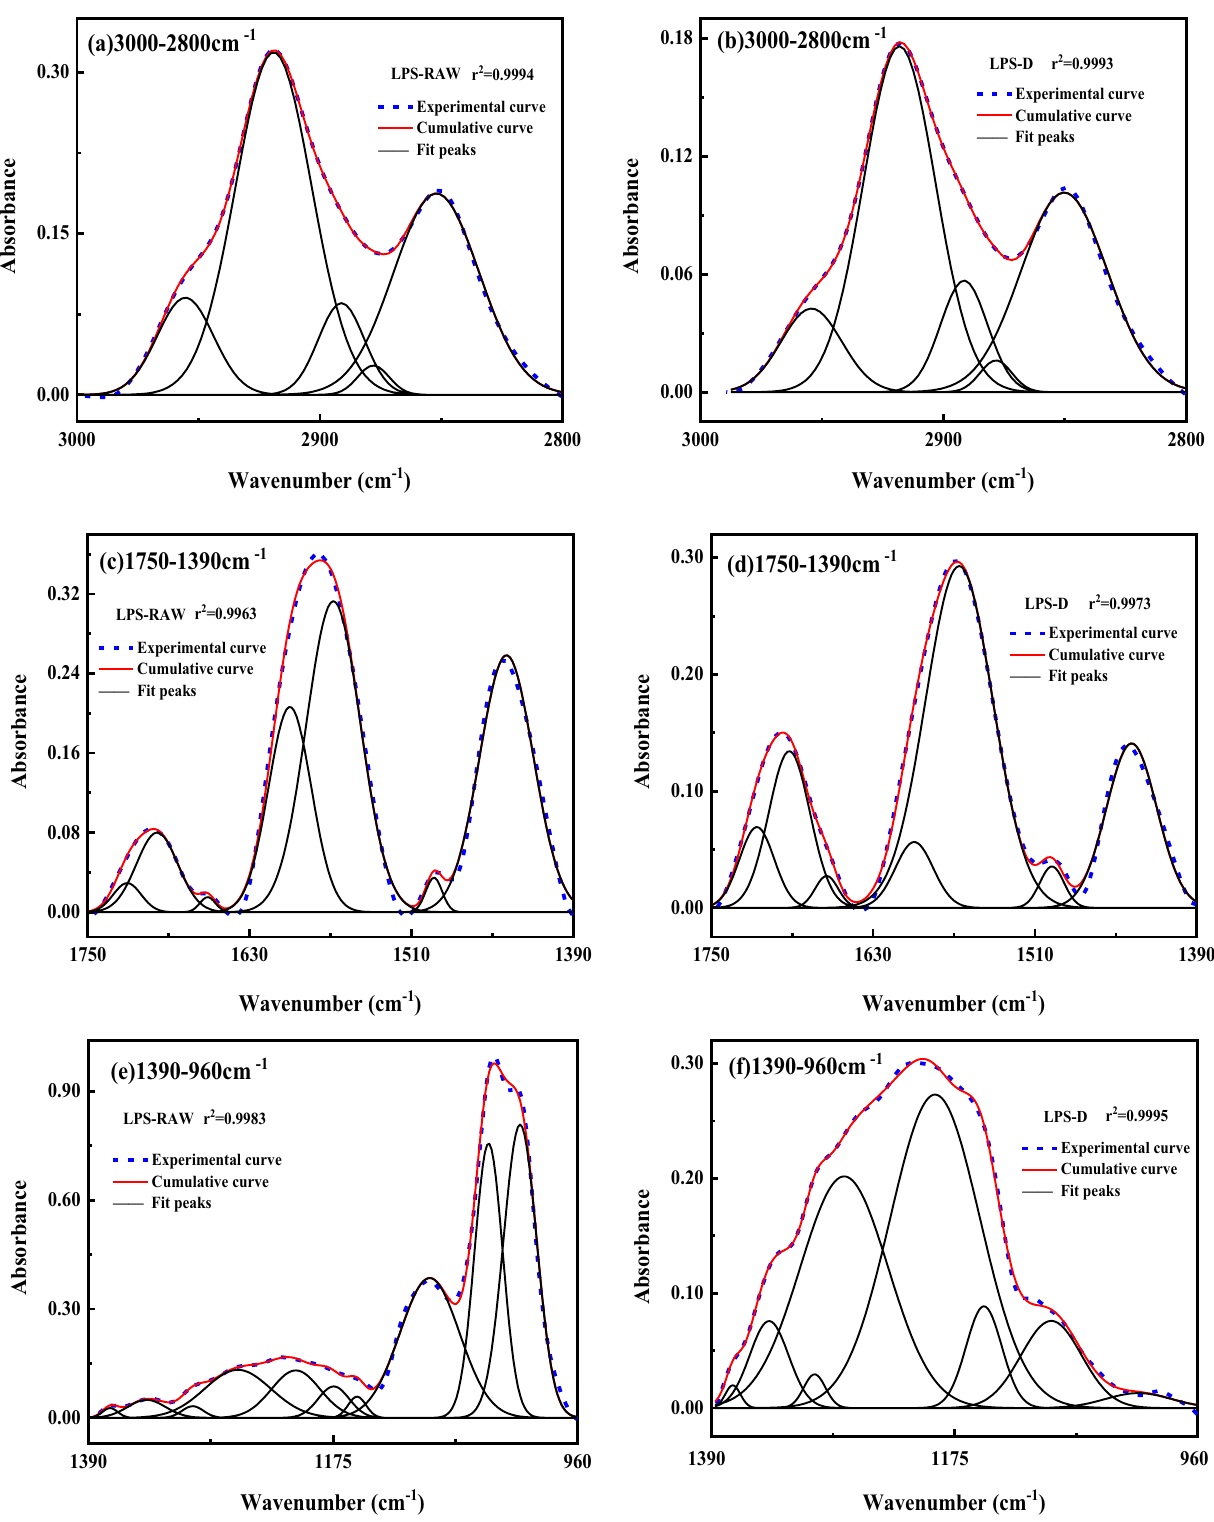
Fig. 2 Curve fittings of LPS-R and LPS-D sample’s infrared spectrum in different wavenumber